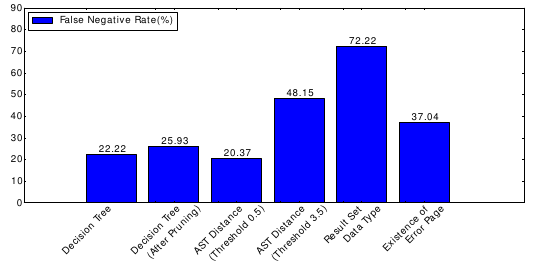
Figure 8. FNR Comparison with Single Stage Detection